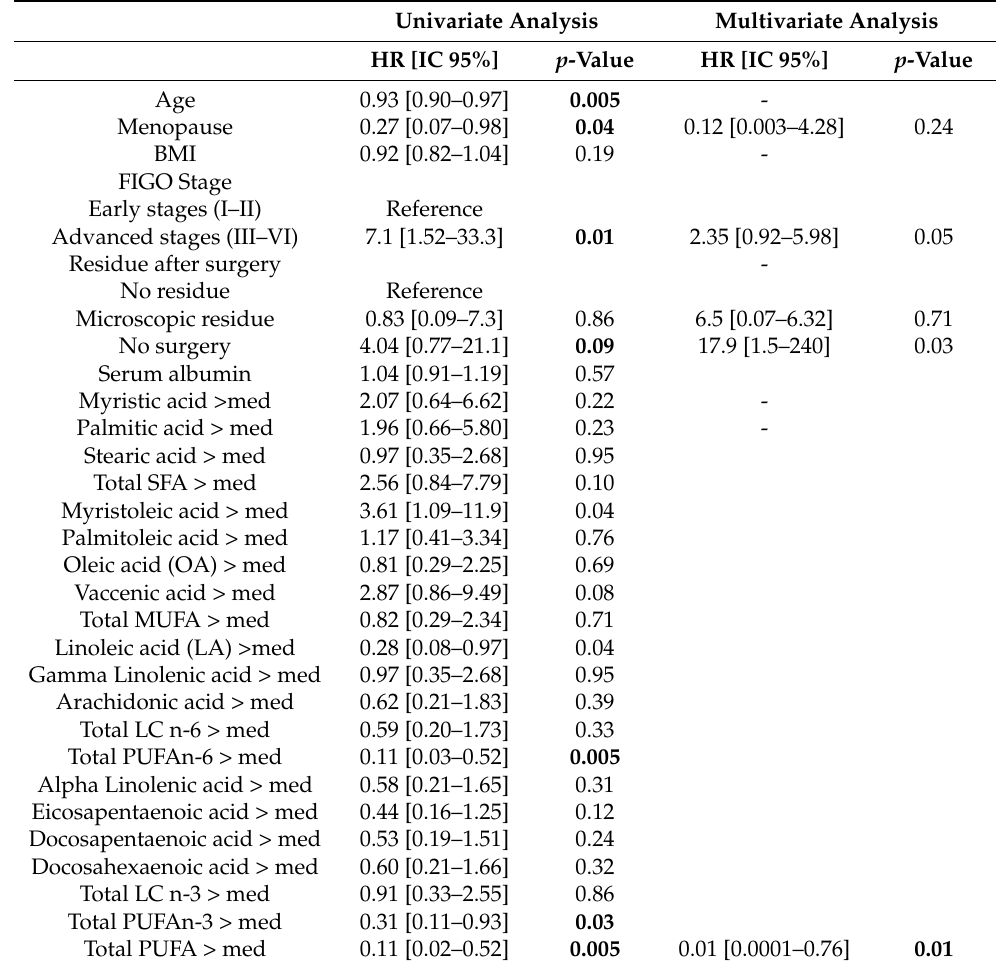
Table 5. Predictive factors for recurrence free survival in women with